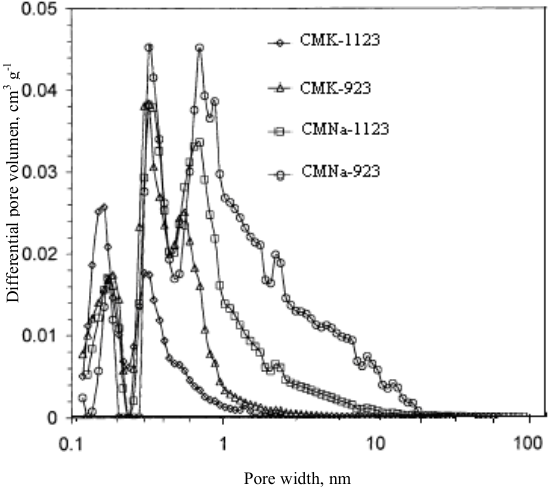
Figure 2. PSDs obtained by applying the DFT theory to N